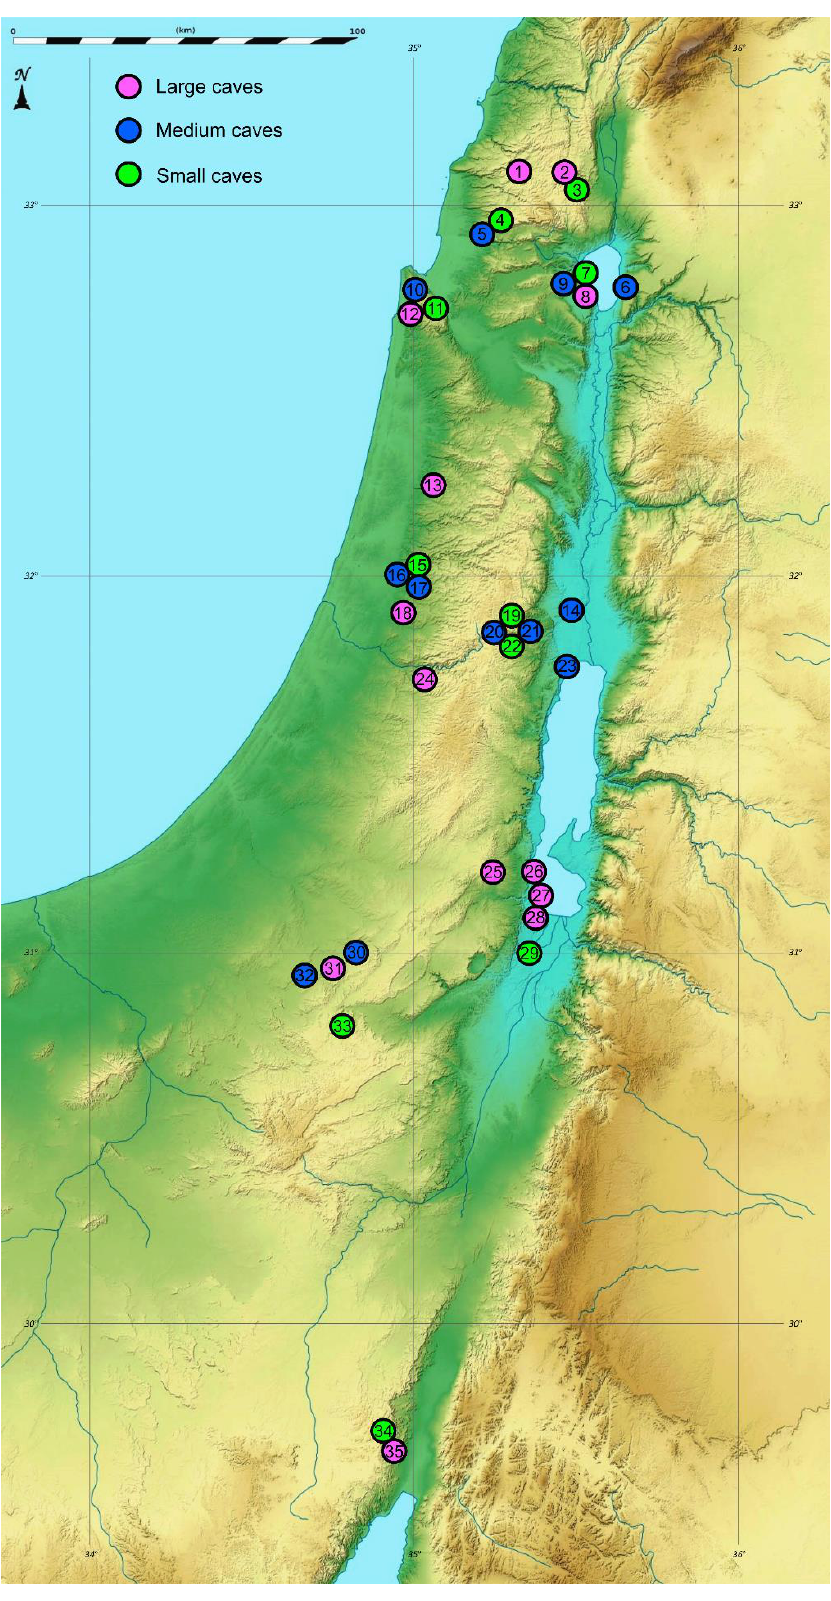
Figure 1. Distribution of the 35 caves. Large caves are represented by pink dots, medium caves by blue dots, and small caves by green dots. Numbers denote a specific cave (see Appendix A).